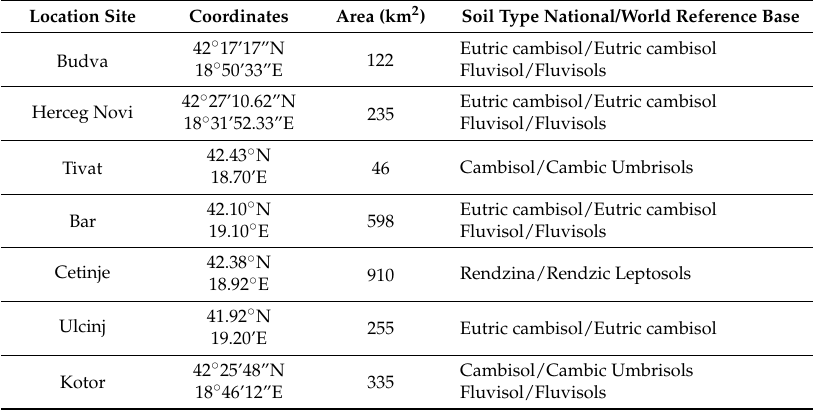
Figure 1. The map of a study area with sampling locations. Table 1. Coordinates, area and soil types of sampling sites.